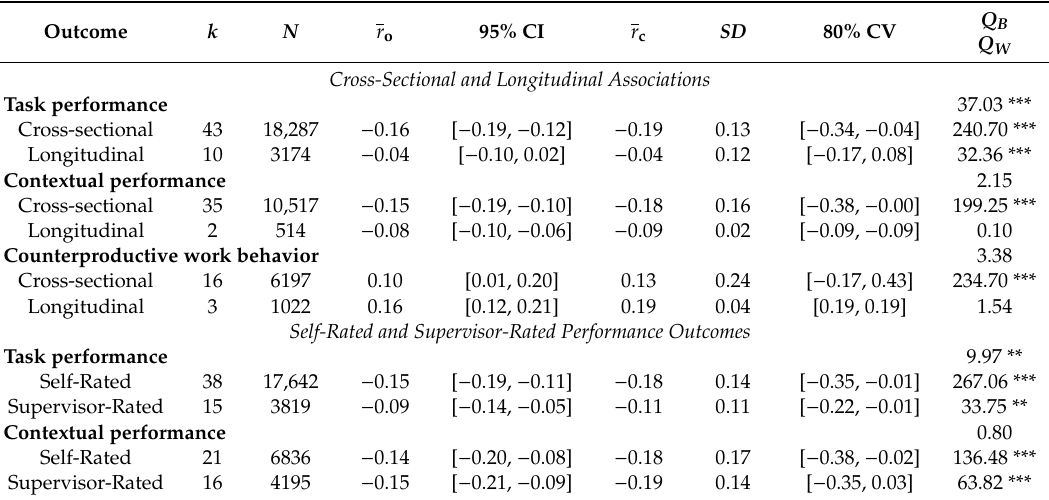
Table 3. Meta-analytic results by method-related